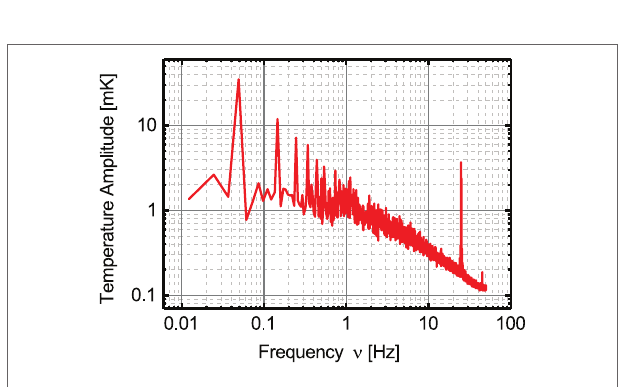
FigURe 12 | Measured temperature amplitude spectrum for a multifrequency excitation signal as shown in Figure 11